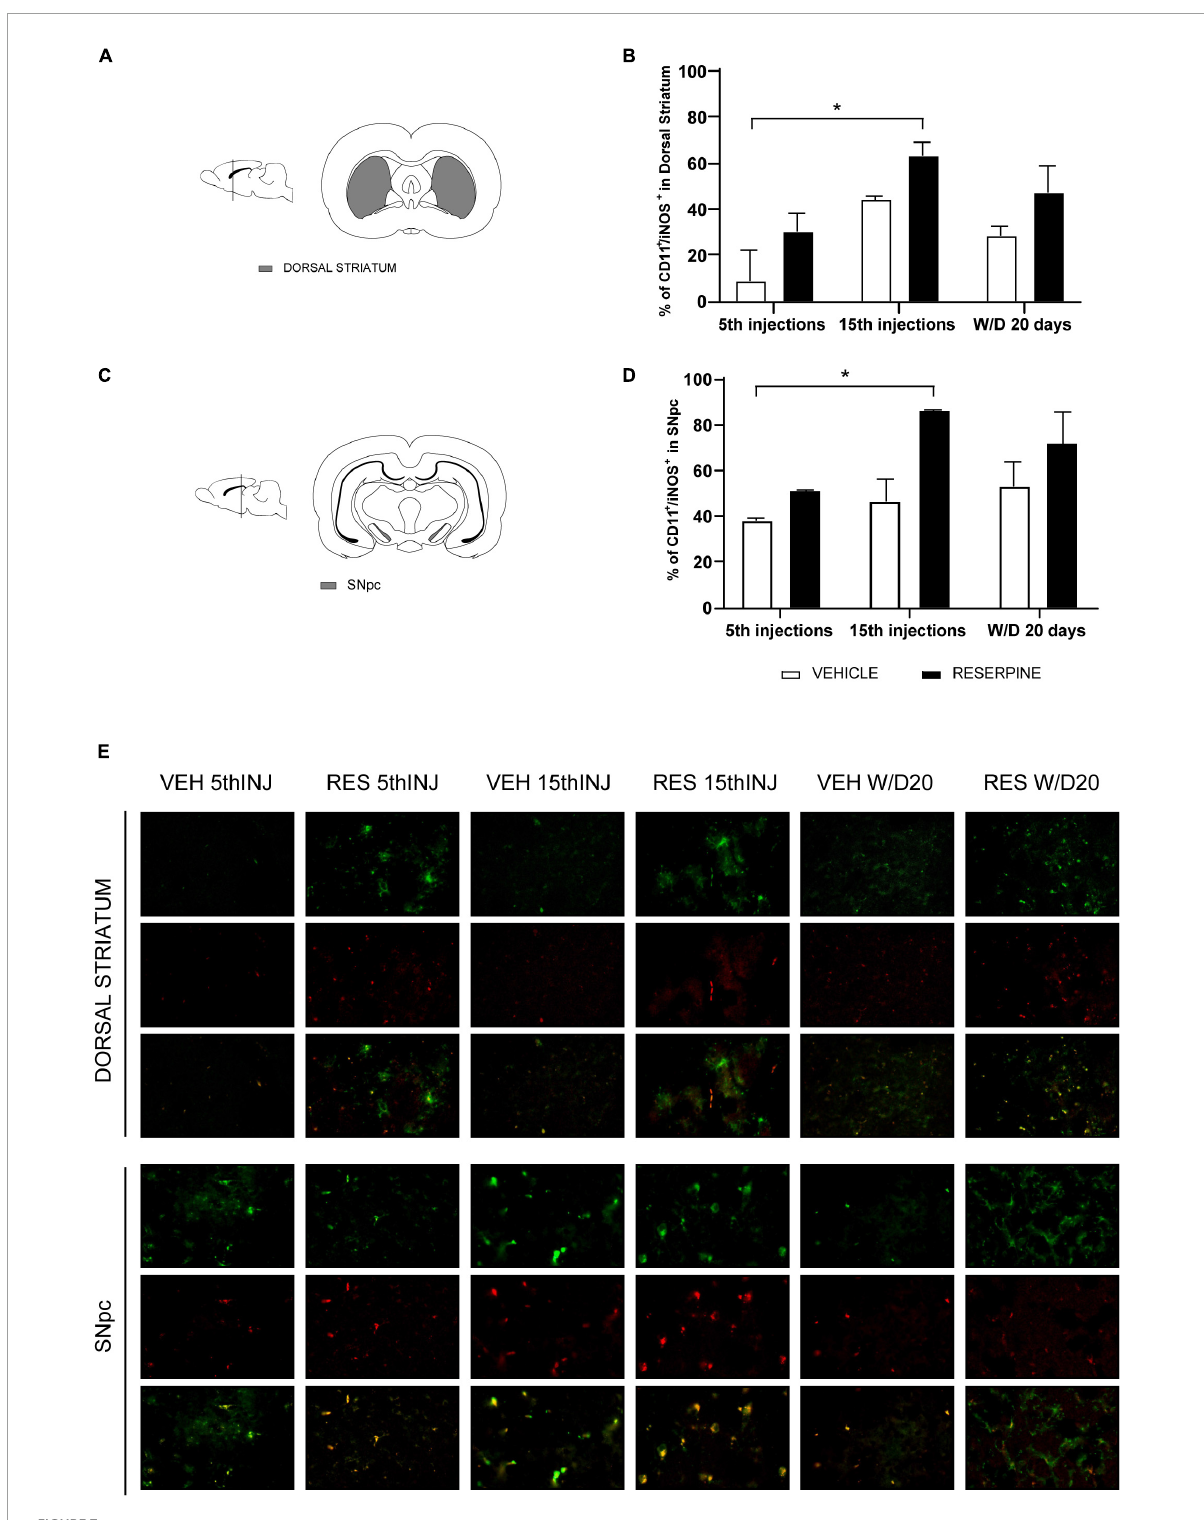
FIGURE7 Coronal slice scheme of Dorsal Striatum (A) and SNpc (C) ; effects of repeated administration of 0.1 mg/kg reserpine ( n = 3) on immunofluorescence with double labeling for CD11b (green) and iNOS (red) expressed by percentage of CD11 + /iNOS + cells in Dorsal Striatum (B) and SNpc (D) ; and representative photomicrographs of immunofluorescence in SNpc coronal sections and Dorsal Striatum (E) . Data are shown as mean + SEM, * p < 0.05 comparing Reserpine and Vehicle groups (ANOVA followed by Sidak’s test). Magnification